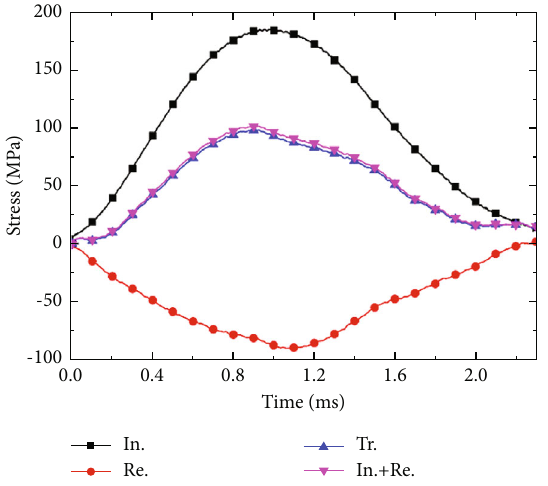
Figure 9: Dynamic stress equilibrium of a typical specimen, D600- 2-2. (note: in., Re. and Tr. denote the incident, re fl ected, and transmitted stresses,